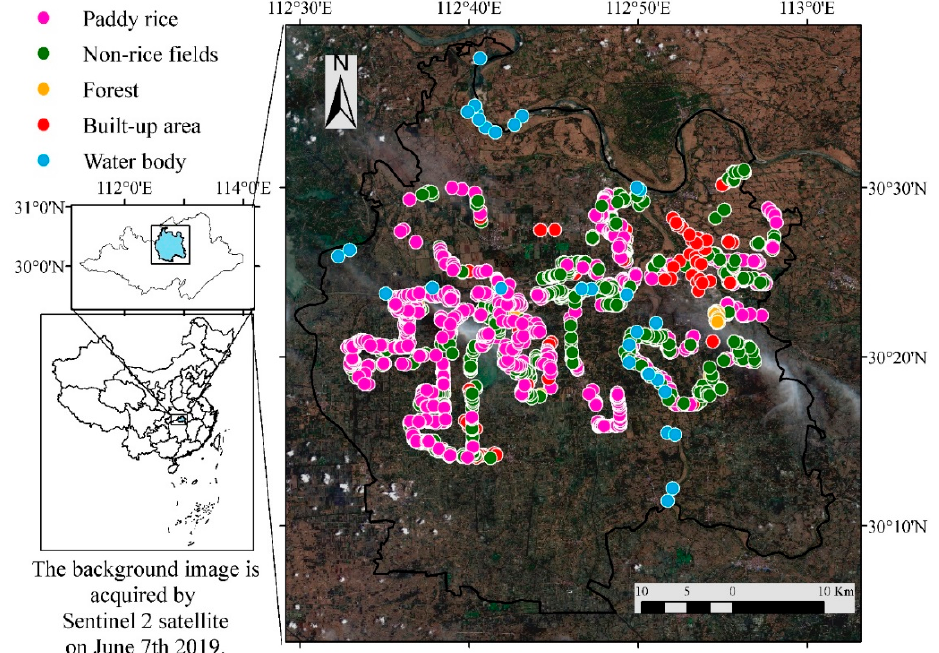
Figure 1. Study area and field survey sample.